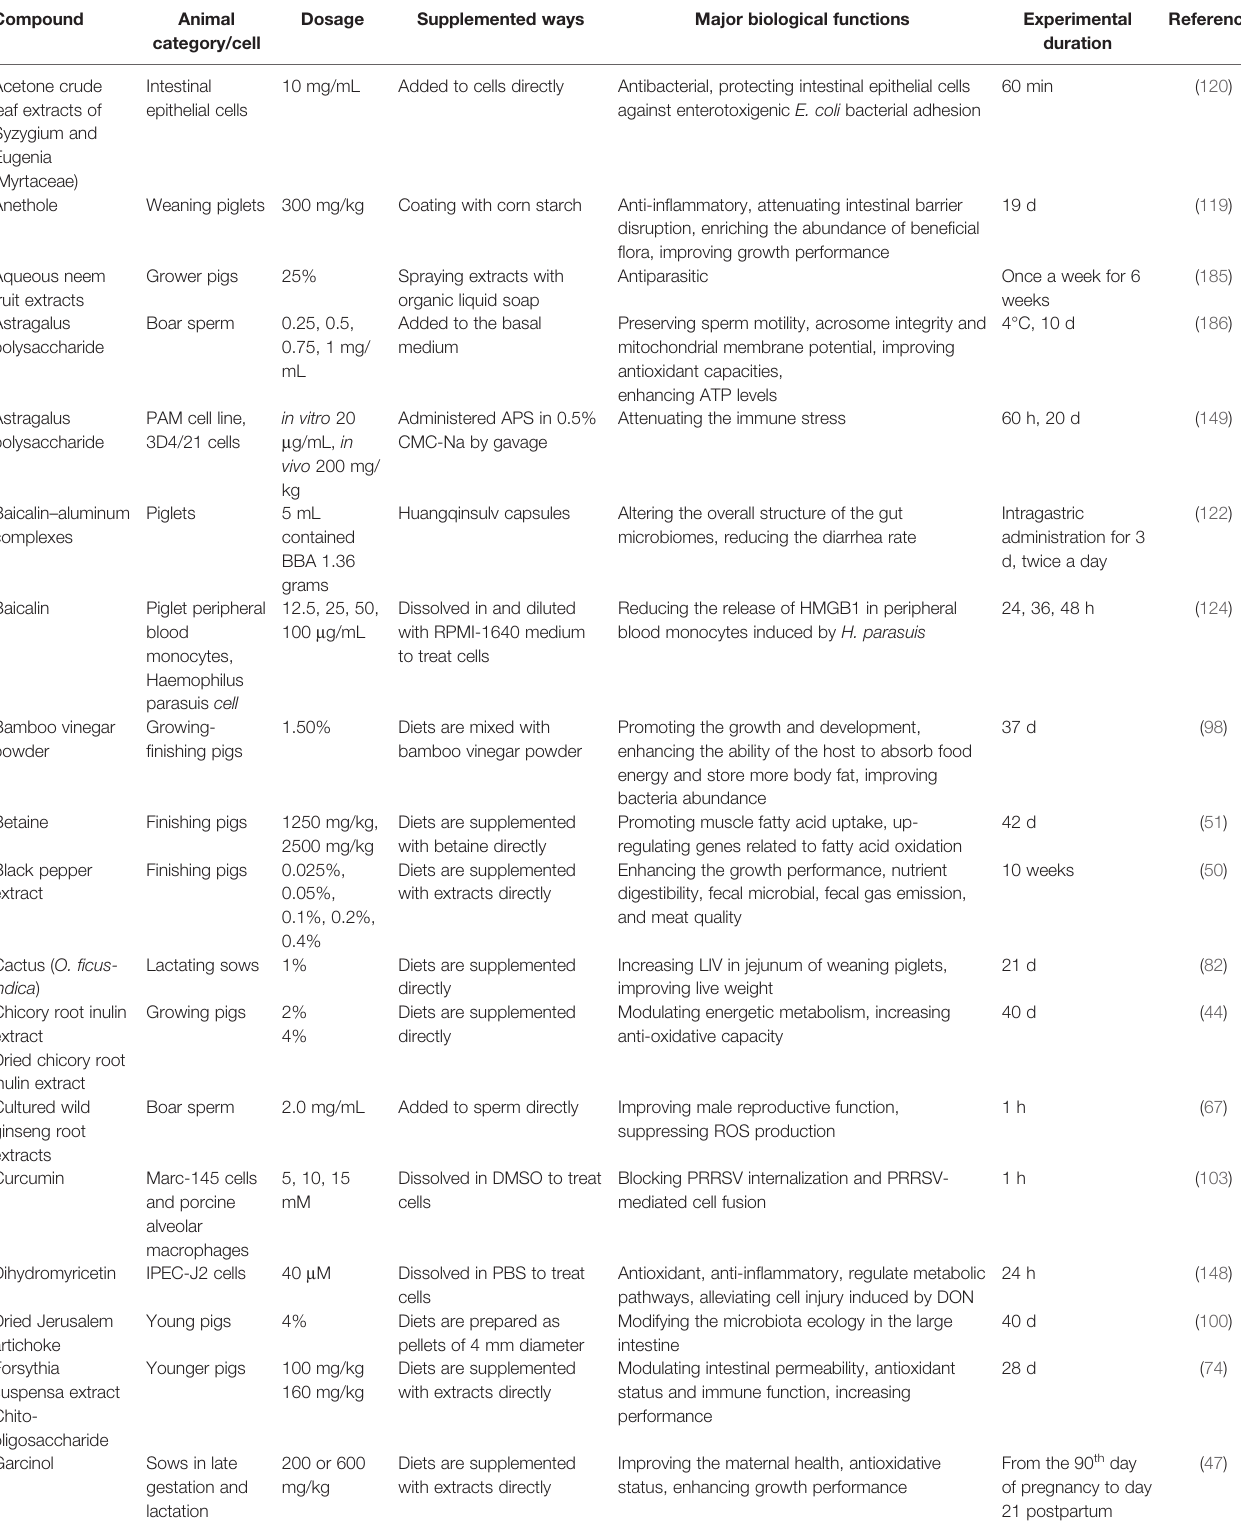
TABLE 1 | Summary of the application of part phytochemicals in pig